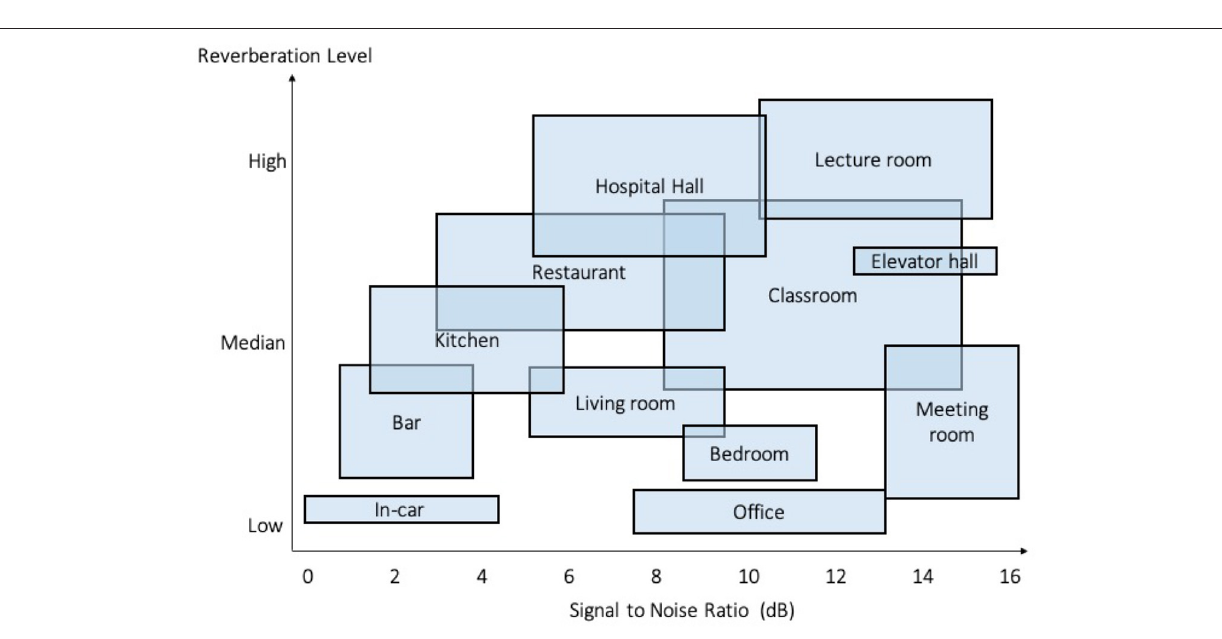
FIGURE 3 | Simulated scenarios in our synthetic datasets, based on the comprehensive analyses of daily acoustic scenarios in terms of noise and reverberation level (27,